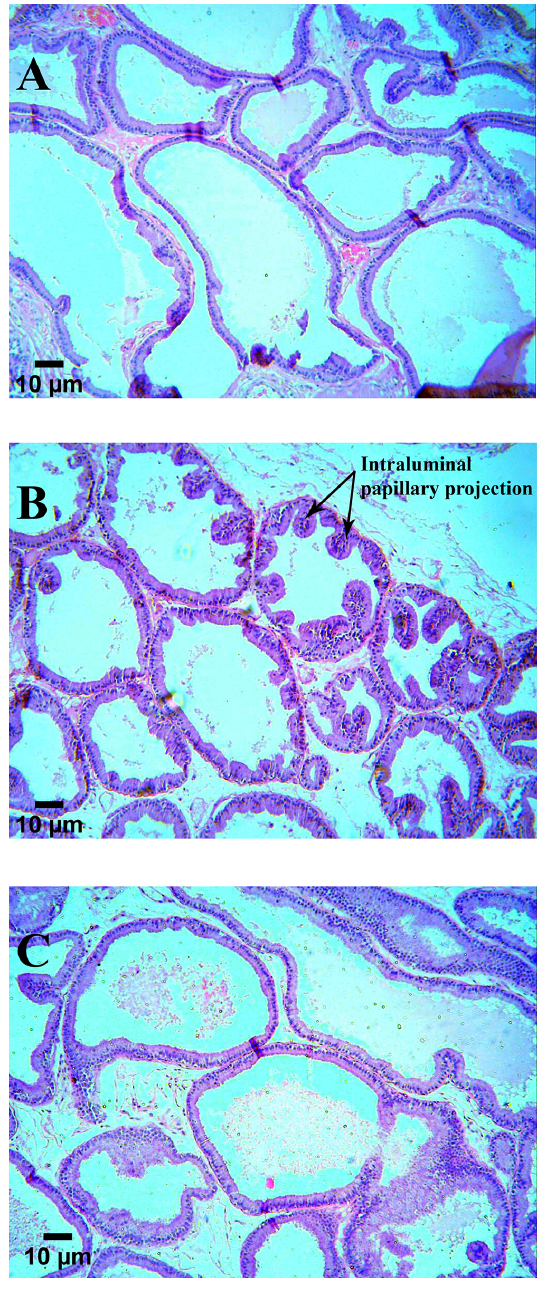
Fig. 3. The histomorphological changes of prostate sections thickness in the experimental rats showing the effect of crocin treatment (hematoxylin staining; magnification, 100 × ) . (A) Control group show normal cellular architecture with normal glan- dular epithelial cells and fibromuscular stromal tissue. (B) BPH group displayed irregular morphology, including a greater level of proliferation in the glandular epithelial and in the fibromuscu- lar stroma with multiple intraluminal papillary projections. (C) Crocin treated group showed that thecorcin treatment amelio- rated histological morphology in the BPH treated rats compared to BPH-untreated group.